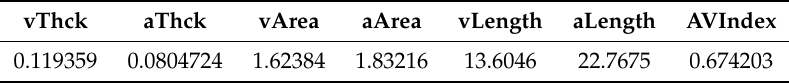
Table 2. Main exported parameters for the image Figure 8,